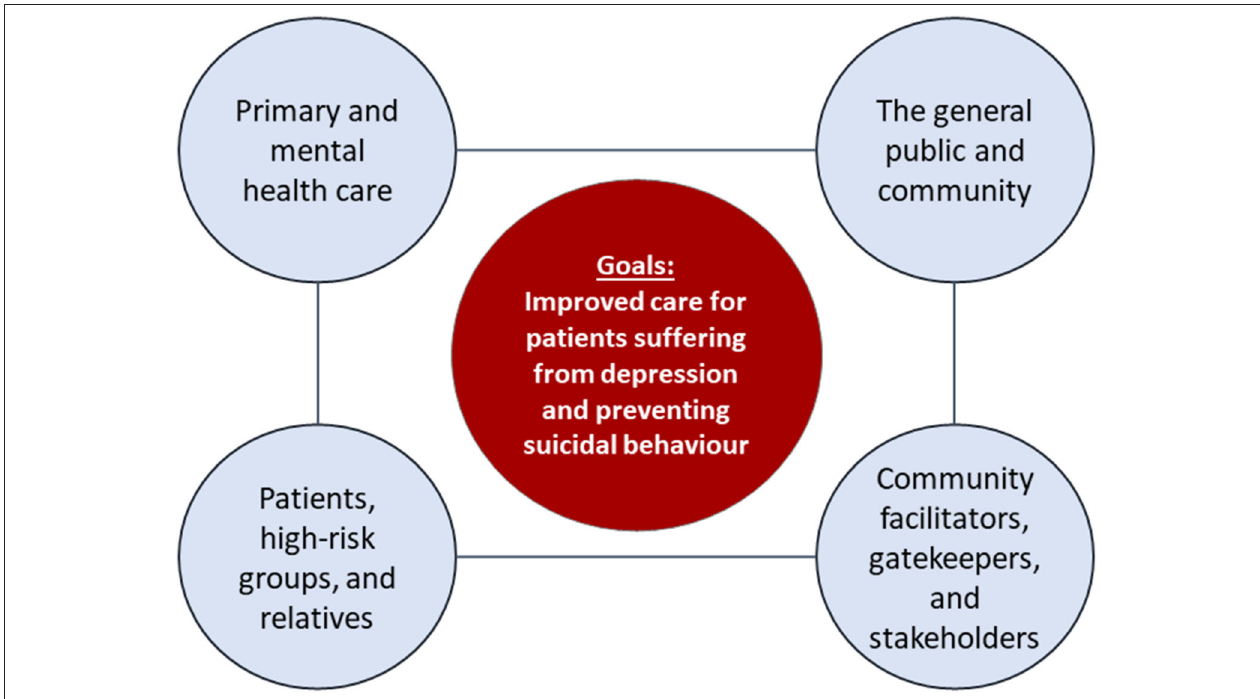
FIGURE 1 | The 4-level intervention concept (reproduced with courtesy of the European Alliance Against Depression e.V.). Level 1—Interventions for primary and mental health care professionals: training sessions and practise support for General Practitioners (GPs) and mental health care professionals regarding the diagnosis and treatment of depression and managing suicidality, including iFightDepression ® , an e-learning guided web-based intervention tool for their patients. For more details on the iFightDepression ® -tool please refer to Oehler et al. (8). Level 2—Interventions for the general public and community: a professional public relations campaign, addressing the general public with the key messages “Depression can affect anyone,” “Depression is a real disease,” and “Depression can be treated.” Generally, regional suicide preventive activities are started by an opening ceremony in a public place, together with a famous spokesperson. Level 3—Interventions for community facilitators, gatekeepers, and stakeholders: training sessions concerning the topics depression and suicide risk for community facilitators and gatekeepers such as geriatric care givers, priests, pharmacists, police, and journalists. These trainings involve role-plays on topics such as how to explore suicide risk and mental ill-health. Cooperation with journalists is based on a media guide with the aim to reduce copycat suicides (Werther effect). Level 4—Interventions for patients, high-risk groups, and relatives: support for patients and their relatives by providing information on depression and the iFightDepression ® tool, supporting other self-help activities and providing an emergency card for people after an attempted suicide. An important aspect of suicide prevention, reducing access to lethal means, is considered in different levels (e.g., smaller package size of lethal drugs, identification and securing “hot spots” for suicide in the community). For more details please see Hegerl et al.